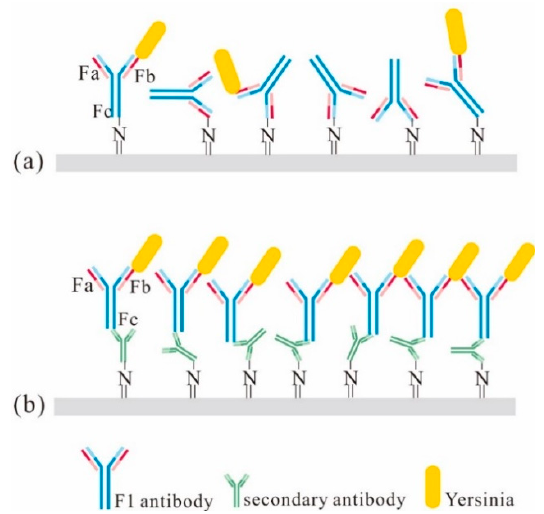
Figure 7. Microcantilever surface modification ( a ) without and ( b ) with a secondary antibody.